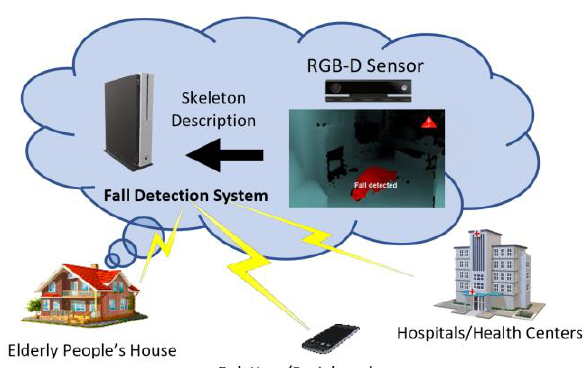
Figure 1. The basic overall architecture of the proposed system